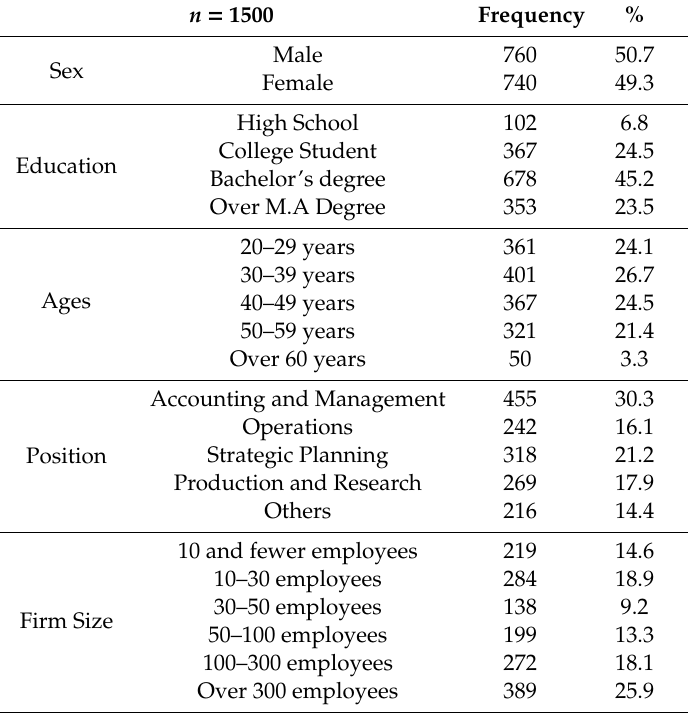
Table 1. Demographic